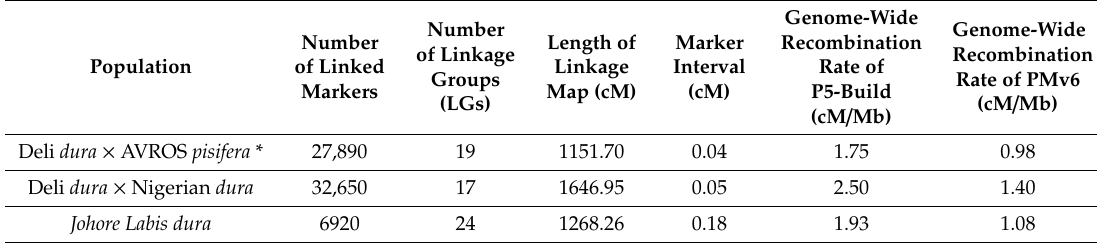
Table 1. Statistics of linkage maps developed for each oil palm